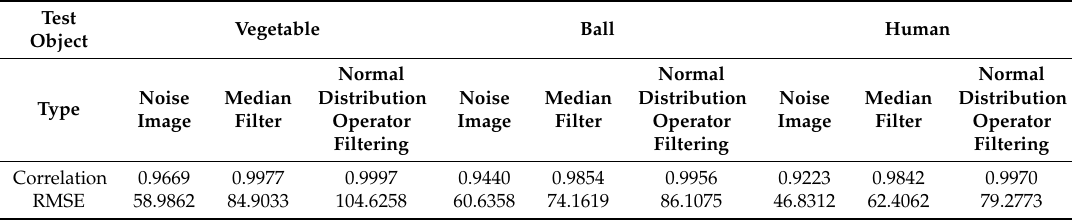
Table 1. Correlation and RMSE values of filtering effects of different filtering